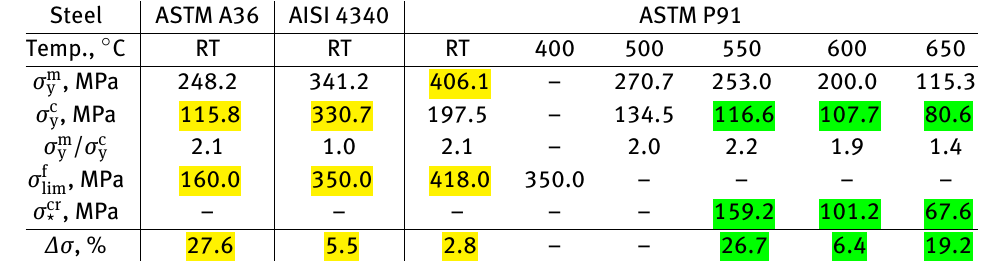
Figure 7: Elliptic yield surfaces of ASTM P91 steel using temperature-dependent σ m y and σ c y from Table 4. Table 4: Comparison of σ m y , σ c y , σ f lim and σ cr * for ASTM A36, AISI 4340 and ASTM P91 steels.